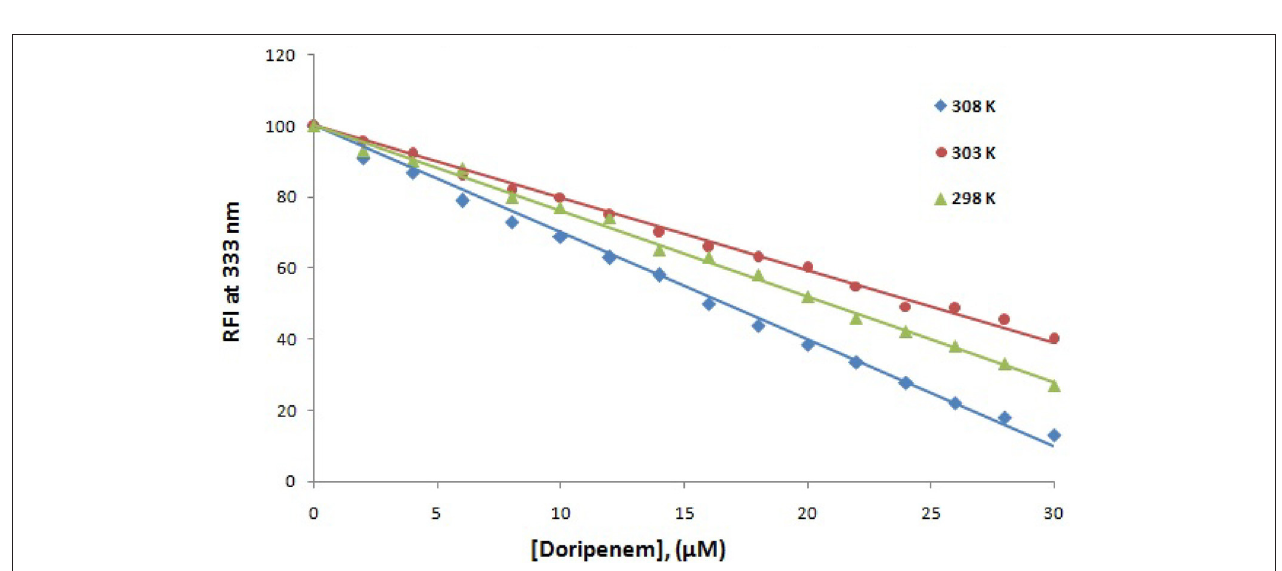
FIGURE 4 | Modified Stern-Volmer plot for quenching of CTX-M-15 (2 µ M) in presence of doripenem (from 0 to 30 µ M) in 50 mM sodium phosphate buffer at pH 7.4 is shown.